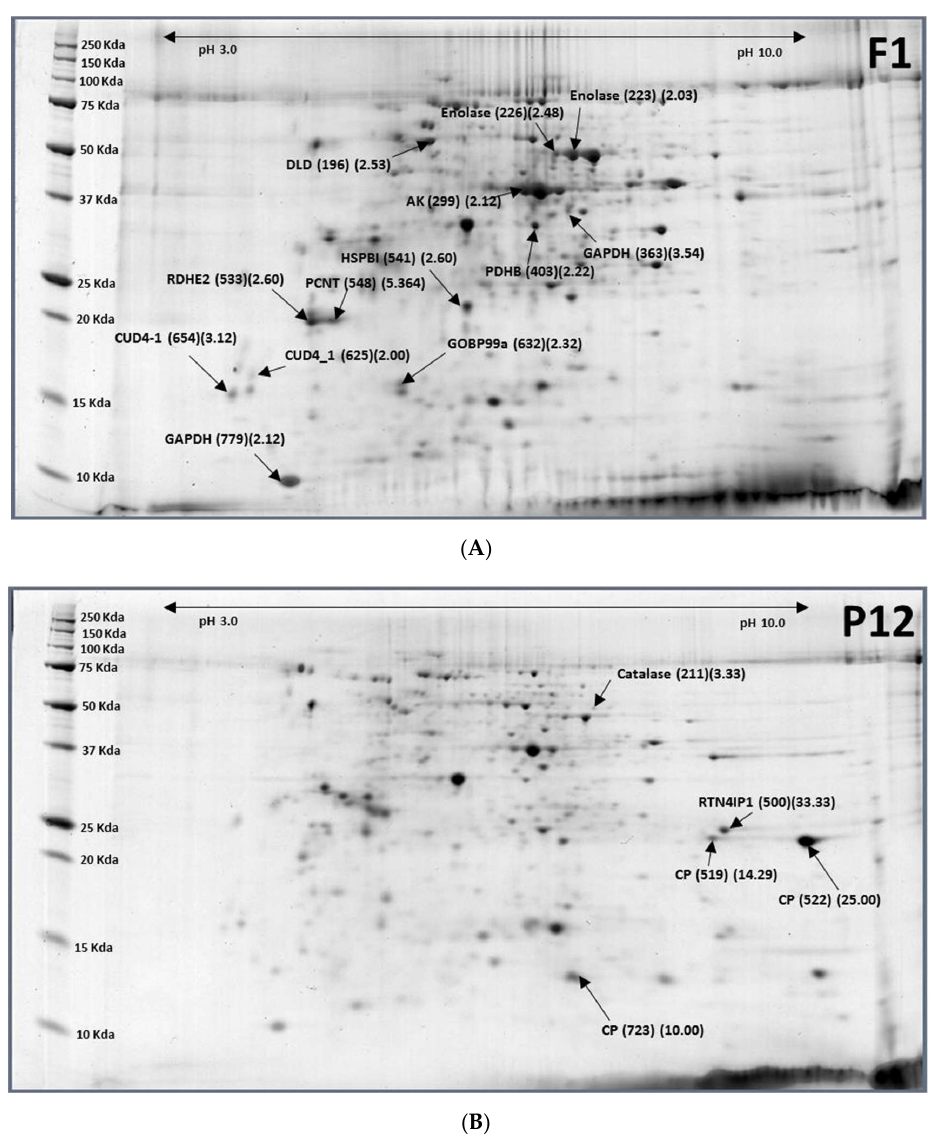
Figure 3. Representative images of 1-day-old females (F1) ( A ) and 12-day-old pupae (P12) ( B ) of Bactrocera latifrons . Images were labelled with protein names (spot ID#) (F1/P12 ratios). 2.4. Pupae (12-Day-Old, P12) to Males (1-Day-Old, M1) Major differentially expressed protein between 12-day-old pupae and 1-day-old males were six down-regulated protein spots containing four cuticle proteins and six up-regulated protein spots including six proteins-DLD, enolase, Heat shock protein cognate four (Hsc70-4), Arginine kinase (AK), DNA polymerase theta (Pol theta), and endocuticle structural glycoprotein ABD-4 (Table 4; Figure 4). Cuticle proteins were reduced by 89–97% (M1/P12 ratio = 0.03–0.11). Glycolysis proteins such as enolase, DLD, and AK were upregulated to restore from hibernated pupae to adult stage. Enolase (phosphopyruvate hydratase) is a metalloenzyme responsible for the catalysis of the conversion of 2-phosphoglycerate (2-PG) to phosphoenolpyruvate (PEP) in the ninth and penultimate step of glycolysis. AK can maintain ATP levels by the phosphorylation of the so-called “phosphagens”, to rapidly replenish ATP. The function of Hsc70-4 is chaperone-binding/unfold protein-binding. Overexpression of DNA polymerase theta (Pol theta) in Drosophila melanogaster causes reduced